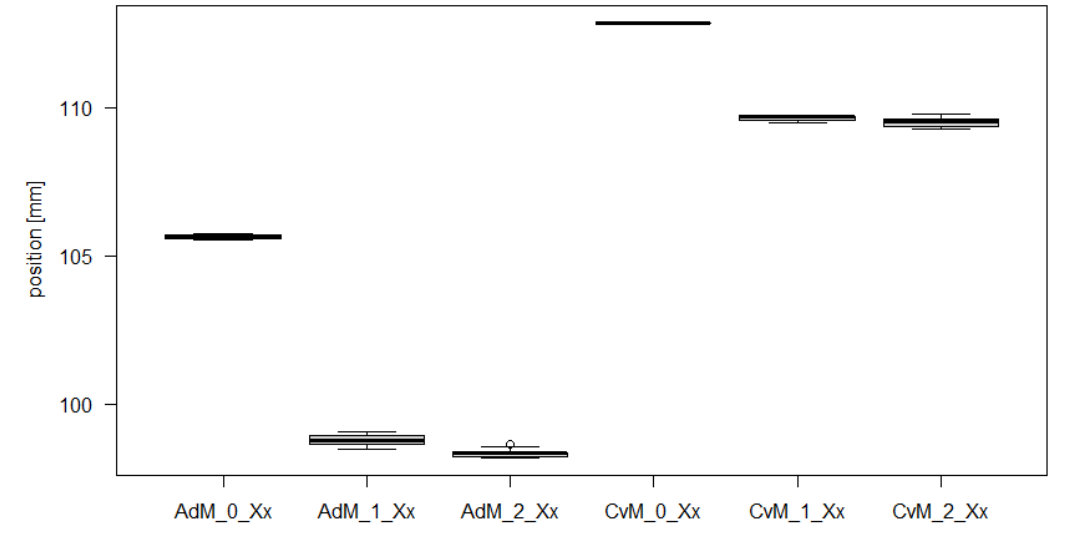
Figure 13. Measurements of CoM axis X.